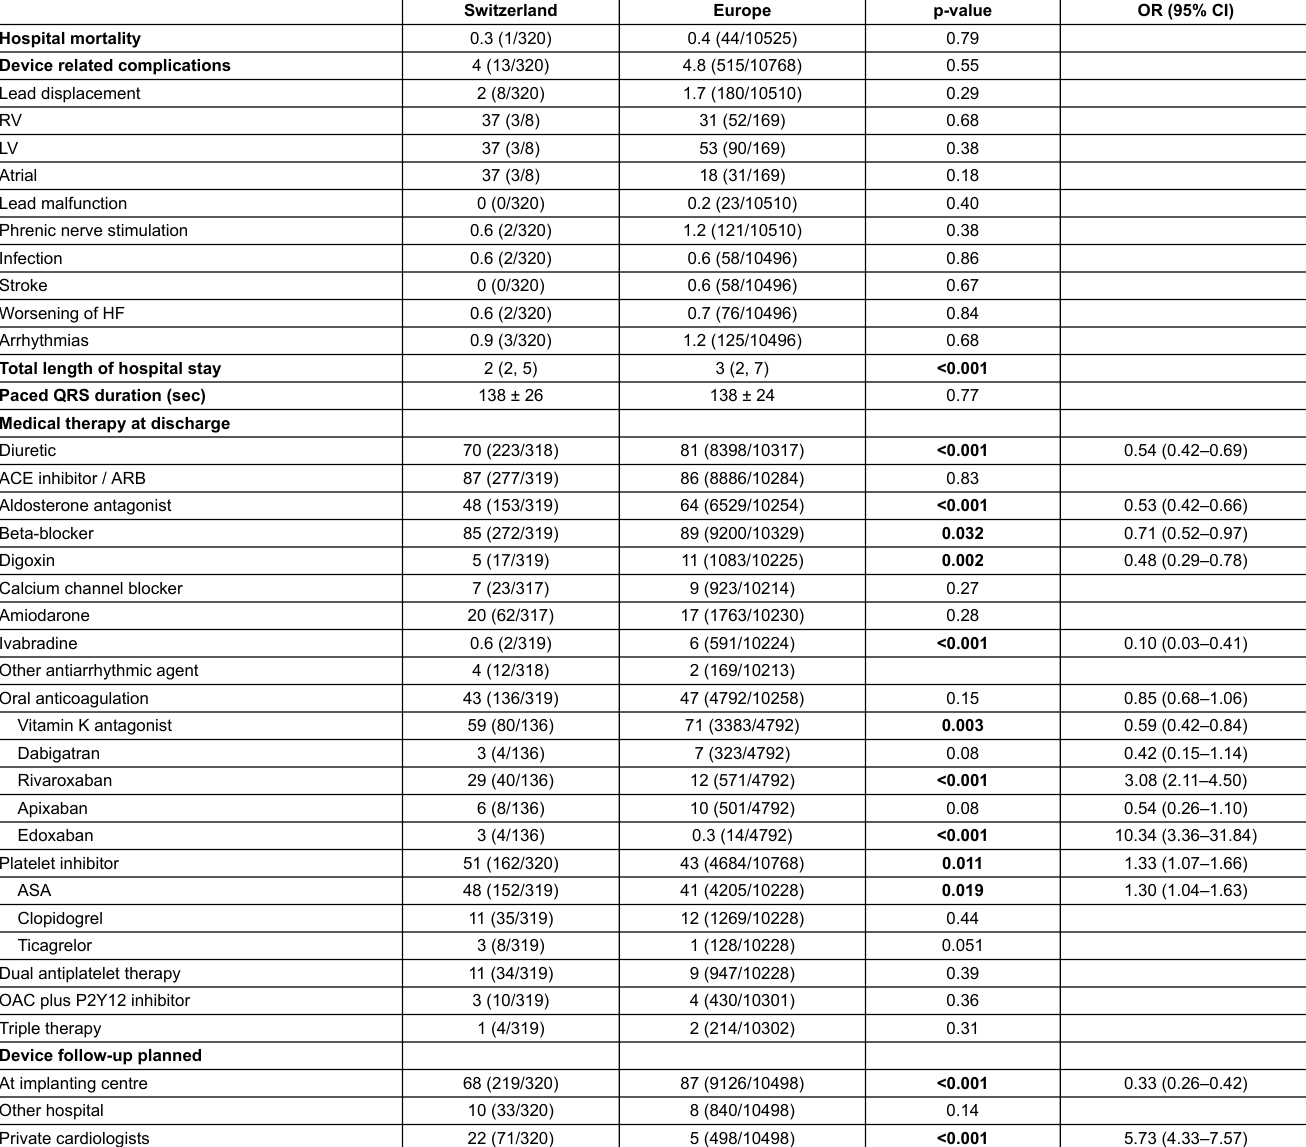
Table 4: Postprocedural data of Swiss cardiac resynchronisation therapy (CRT) population and comparison with the European